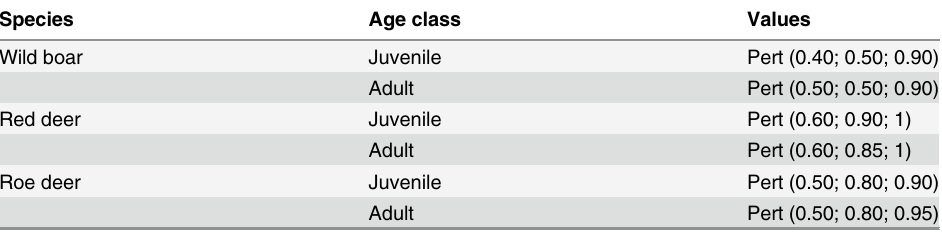
Table 3. Probability of a wild infected animal displaying macroscopic TBLs, as a function of the spe- cies concerned and age